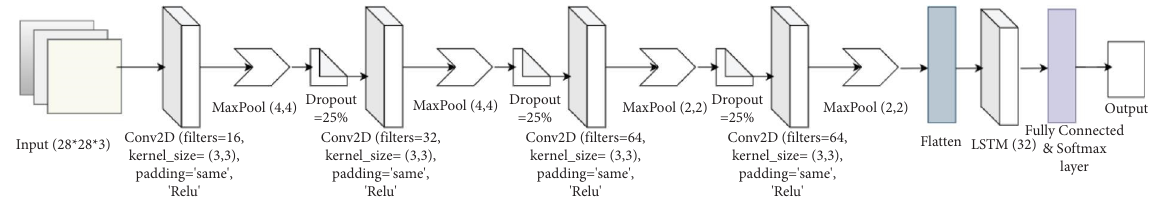
Figure 7: Architecture of the LRCN model.